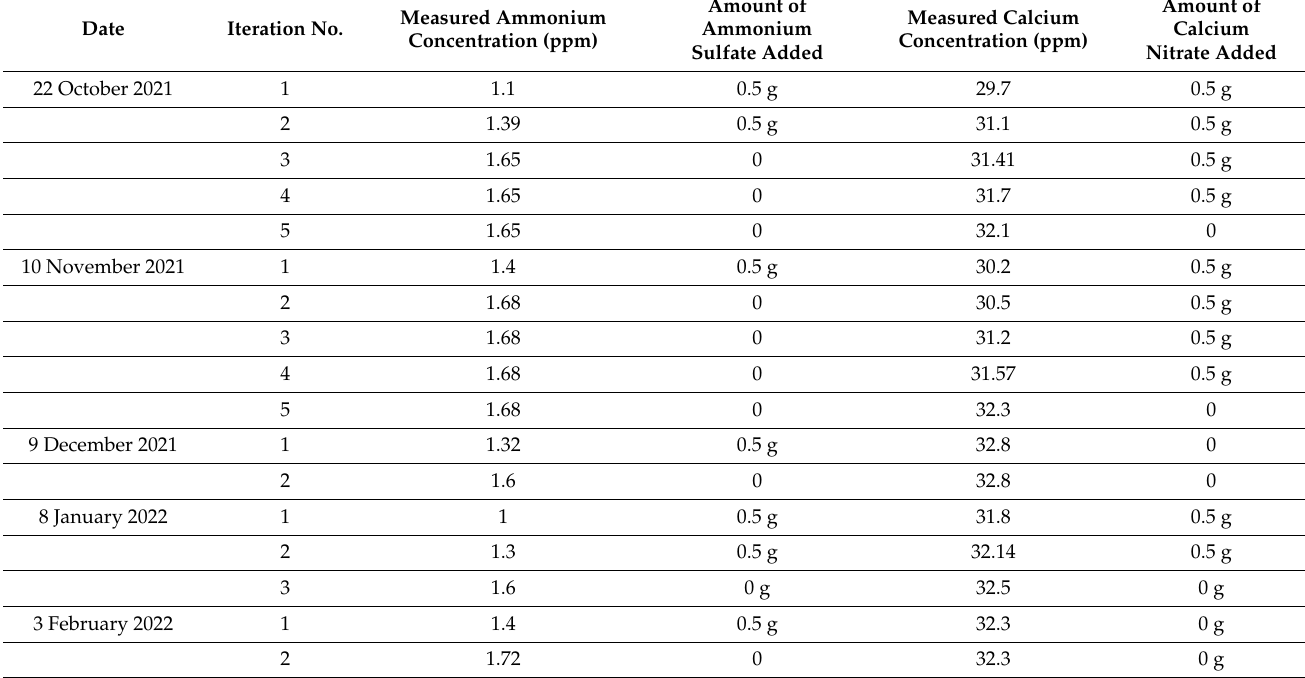
Table 2. Test run to demonstrate control and actuation of nutrients in the IoT